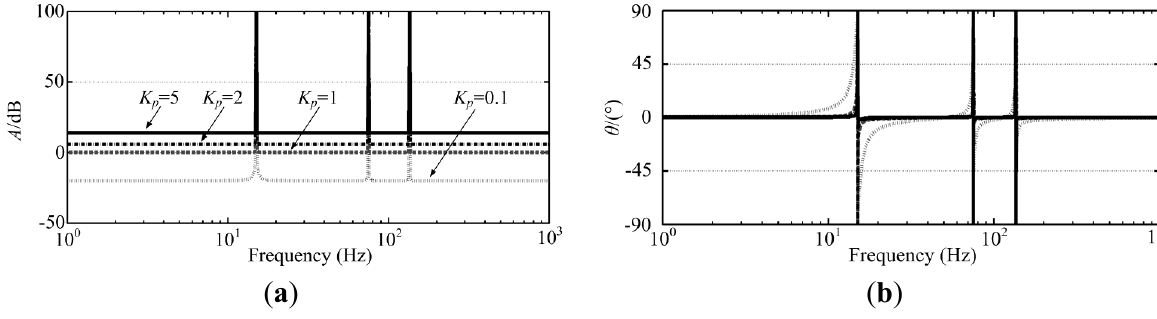
Figure 16. Bode diagram of PR controller with variation of k